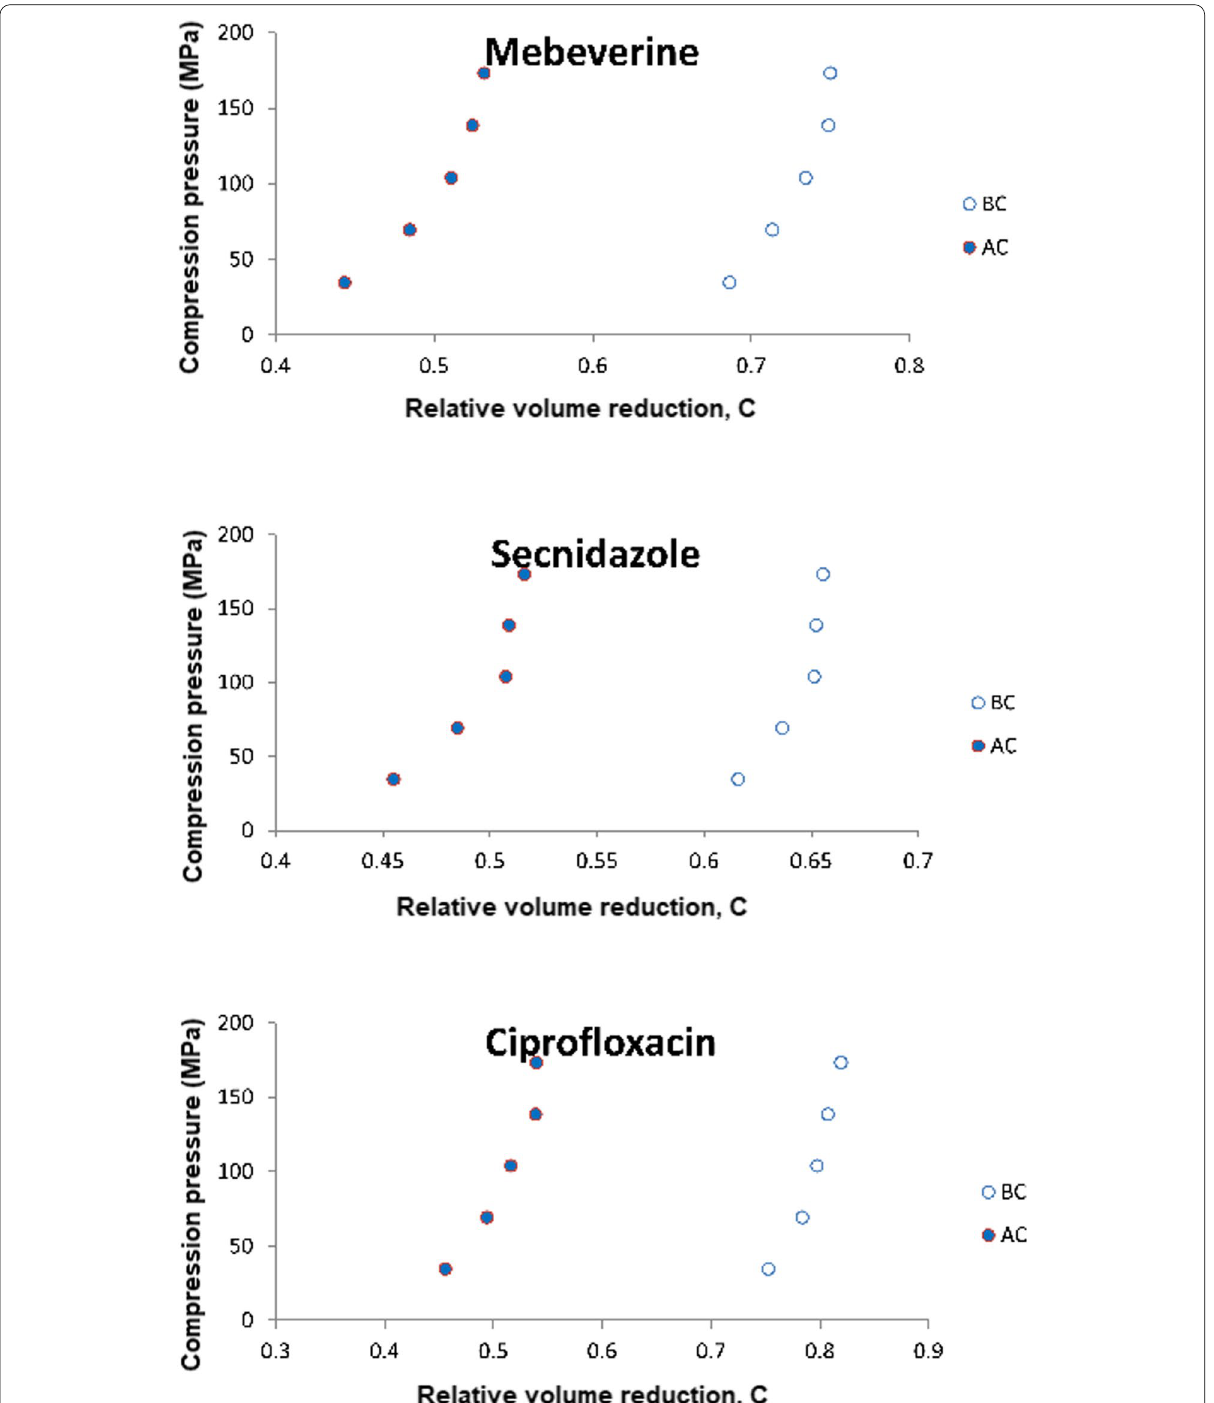
Fig. 7 The compression pressure-relative volume reduction relationship according to Eq. 2 applied to all non-compacted (BC) and compacted (AC) drugs comprising mebeverine, secnidazole, and